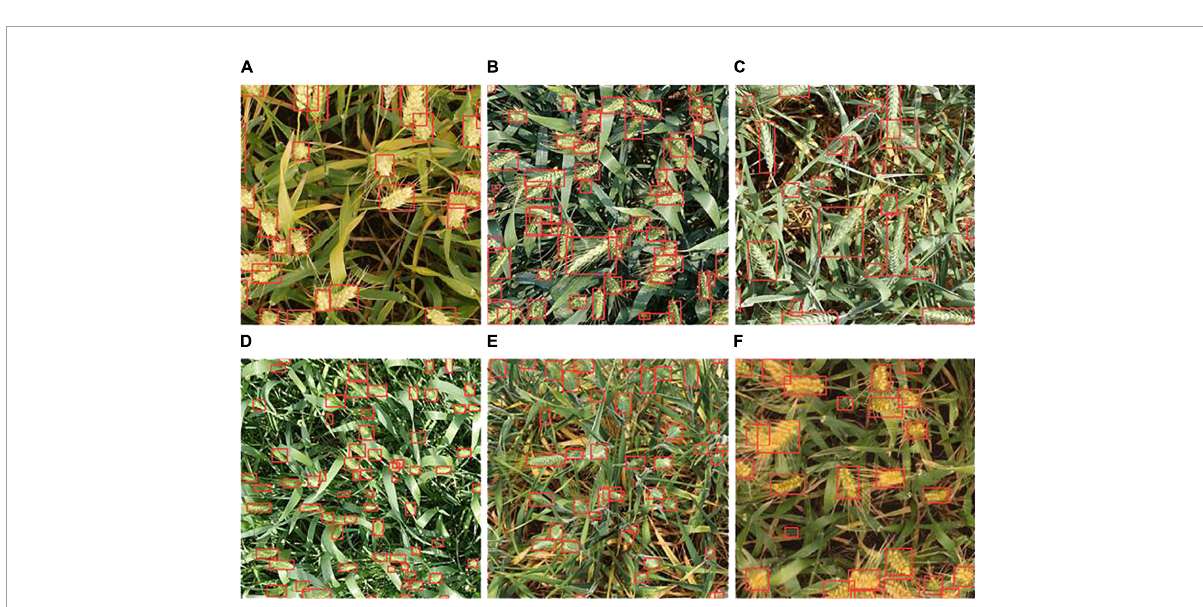
FIGURE9 Experimental effects of improved YOLOv5s under different densities and backgrounds. (A–F) Represent six different images randomly selected from the global wheat challenge 2021 International Conference on computer vision 2021 dataset.